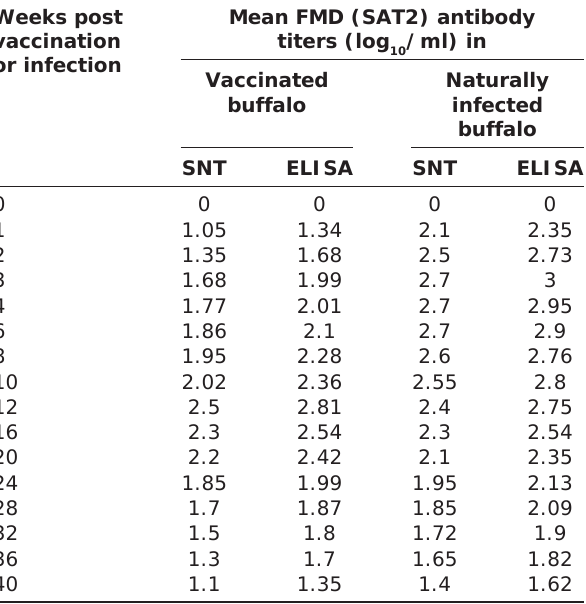
Table-2: Mean FMD (SAT2) antibody titers in sera of vaccinated and infected buffalo by SNT and ELISA. Weeks post vaccination or infection